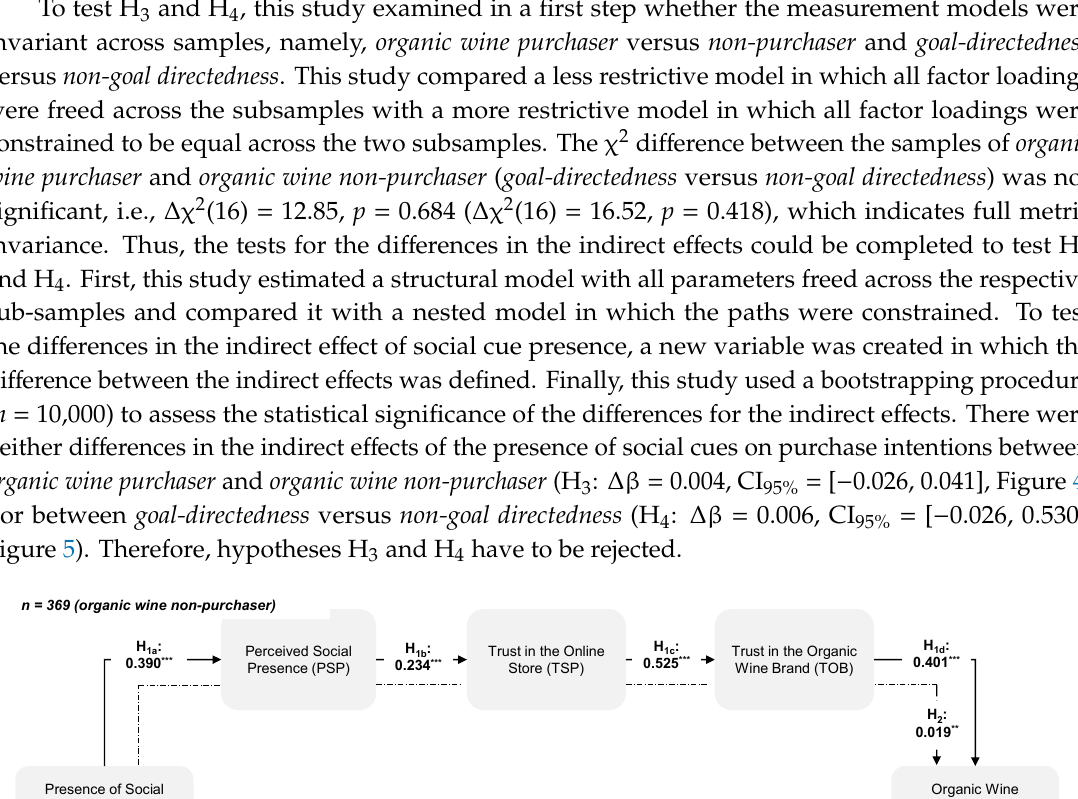
Figure 3. Effects of the presence of social cues on organic wine purchase intentions.